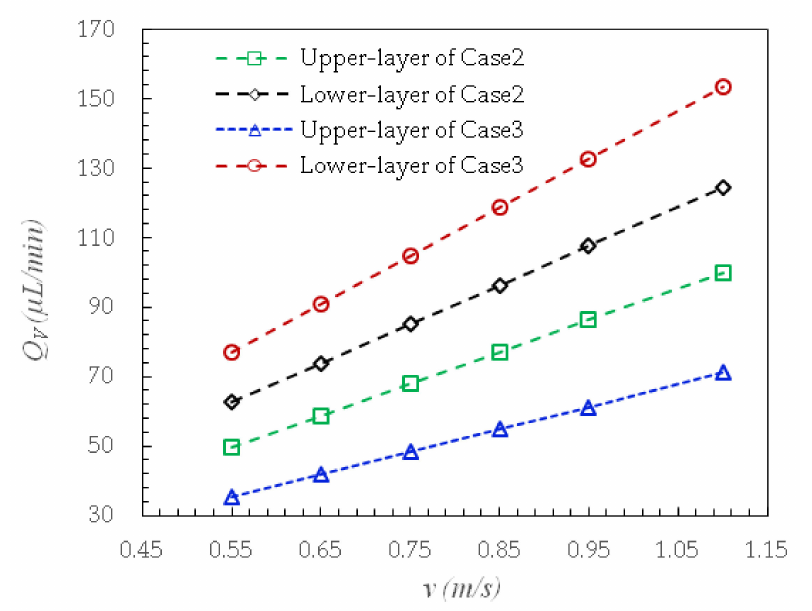
Figure 7. Flow rates at the upper and lower layers for the two proposed heat sinks at different inlet